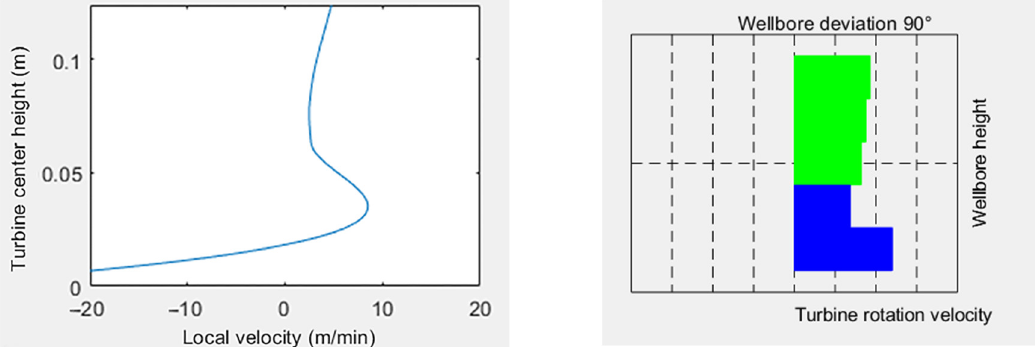
Figure 12. Velocity profile imaging (PD90L120CW40).